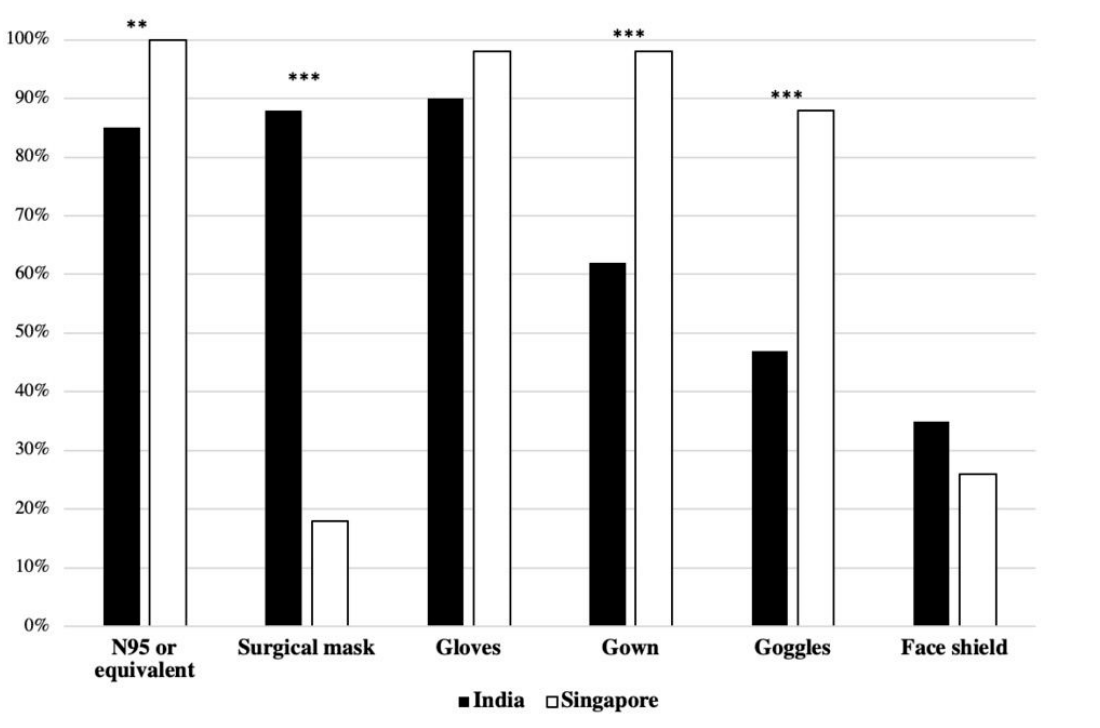
Figure 3. Type of PPE worn by HCW respondents during their shifts in % of respondents in each country (** p < 0 . 01; *** p < 0 . 001).